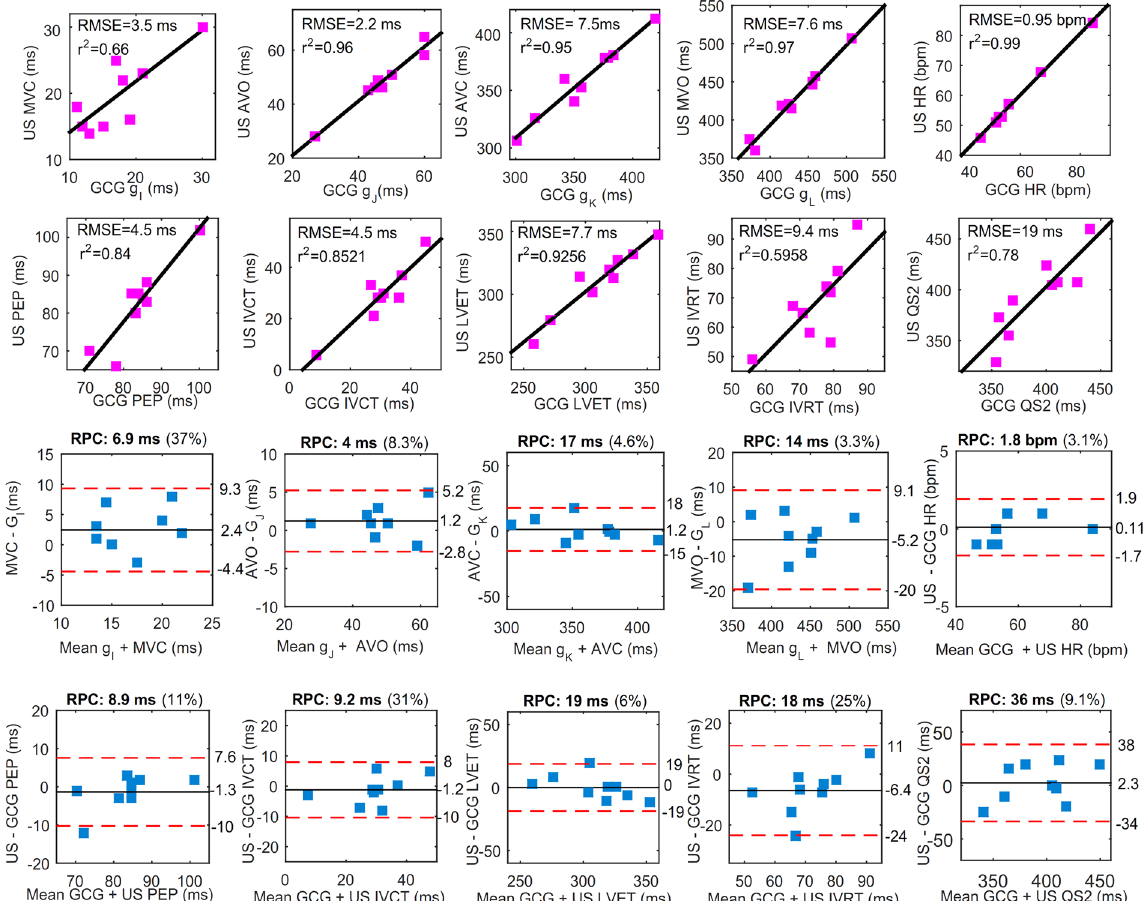
Figure 4. Correlation and Bland-Altman plots. The red color dashed lines drawn in Bland-Altman plots represent the upper and lower LoA ranges for the measured cardiac time intervals. RPC is the reproducibility coefficient value which is the maximum difference that is likely to occur between different observations. The coefficient of variation (CV) percentage is the ratio of the standard deviation and the overall mean.